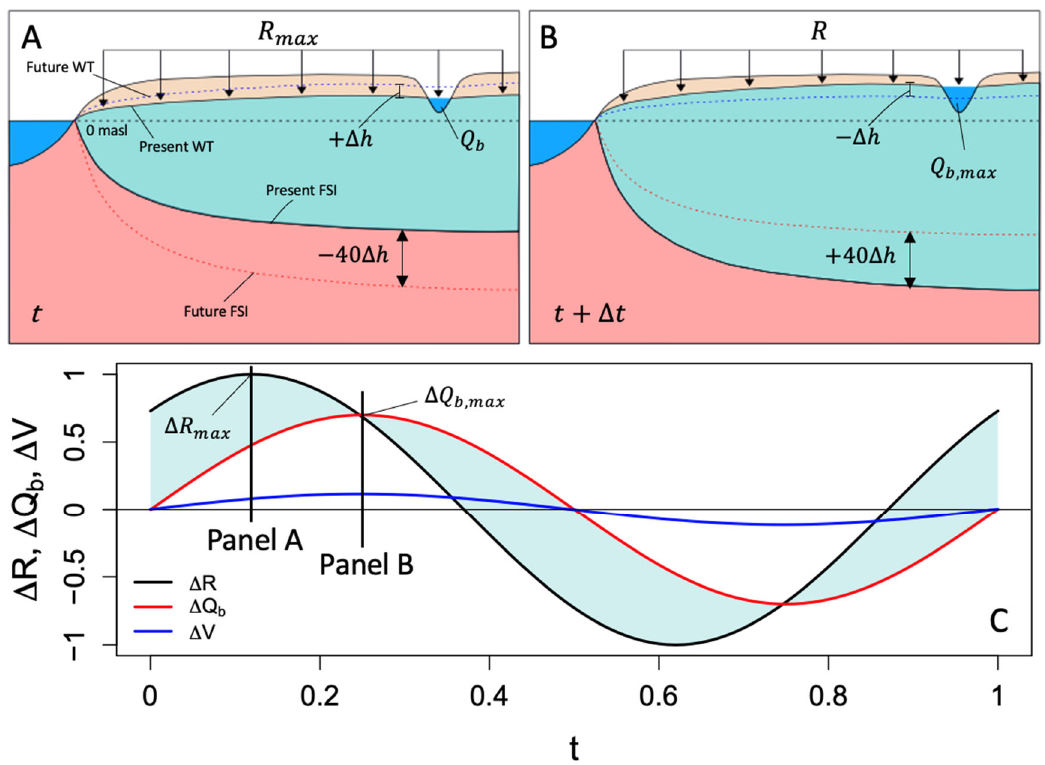
Figure 1. An example of the lagged response of freshwater (light blue), saltwater (light red), and inland baseflow discharge ( Q b ) to an oscillating recharge ( R ) signal in regions with the good hydraulic connection between FSI and the water table (WT). ( A ) During maximum R , the FSI must move down by 40 ∆ h until ( B ) maximum Q b occurs at t = t 0 + ∆ t where the FSI must move up by 40 ∆ h after the decrease in R . ( C ) Integration of R − Q b (black line minus red line) with respect to time shows the periodic change in freshwater storage ( ∆ V ) in blue. Changes in both FSI and WT lag the R signal, and the corresponding current vs. future FSI and WT are shown in panels A and B as dotted lines (red and blue, respectively) compared to the current levels shown as solid black